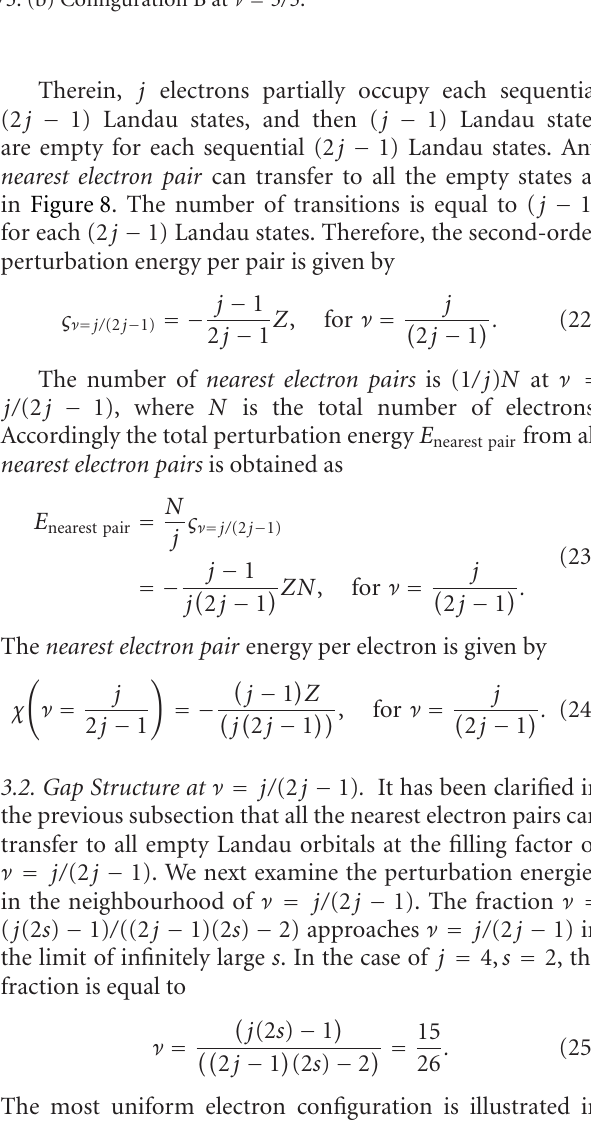
Figure 4: (a) Configuration A at ν = 3 / 5. (b) Configuration B at ν = 3 / 5.